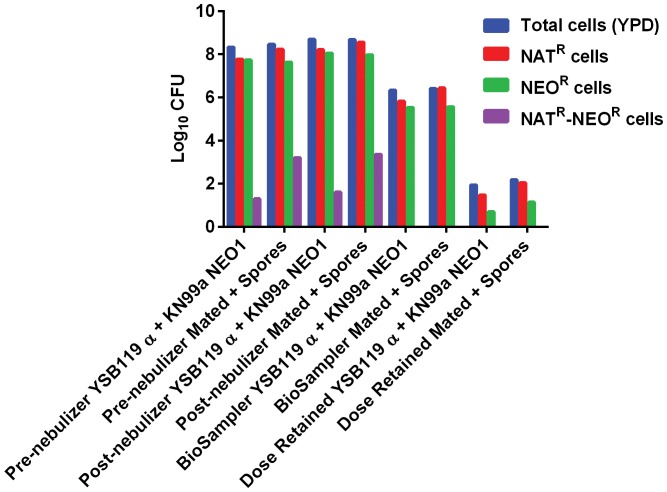
Aerosol delivery of C. neoformans var. grubii (YSB119α and KN99a NEO1) yeast and yeast-spore mixtures.Animal exposure was performed utilizing Cryptococcus strains containing different drug resistance markers. NATR (Red), NEOR (Green), and NATR+NEOR (Purple) resistant colonies were obtained pre- and post- nebulization in similar proportions indicating both yeast and spores equally survive nebulization. NATR+NEOR resistant colonies were not observed from the BioSampler or lung tissues and we observed a net loss of total cell density (Blue) from post-nebuliztion to BioSampler, to dose presented, and to dose retained.